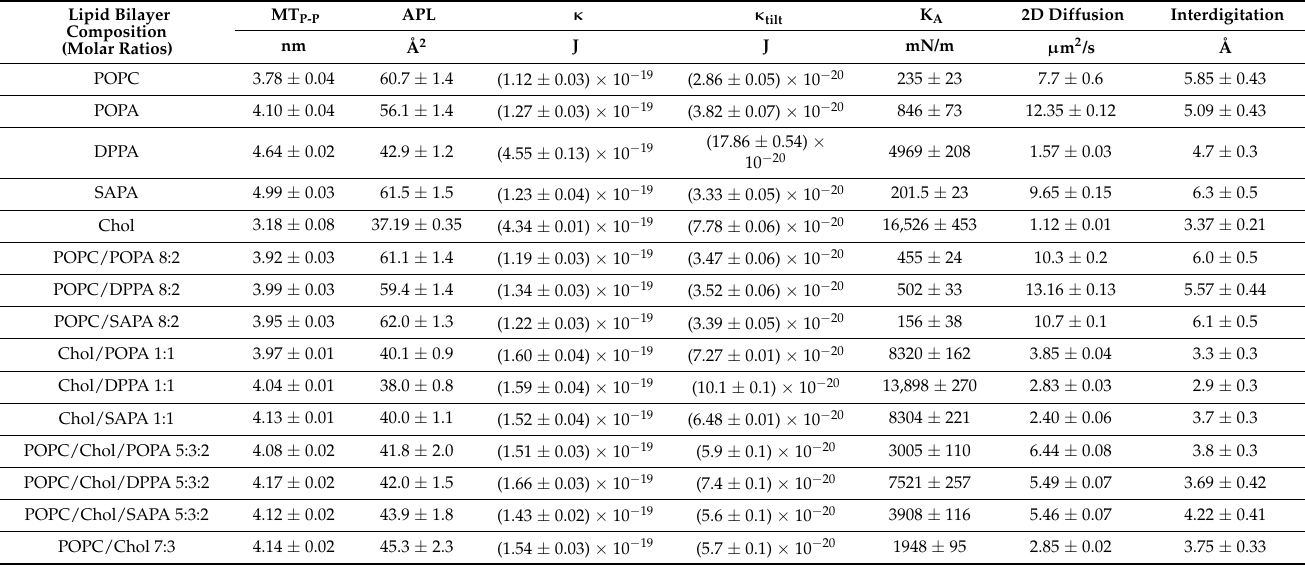
Table 1. Molecular dynamics characteristics of membranes with PA. Presented parameters are calculated for all particles. Distinction for individual lipid species is presented in Table